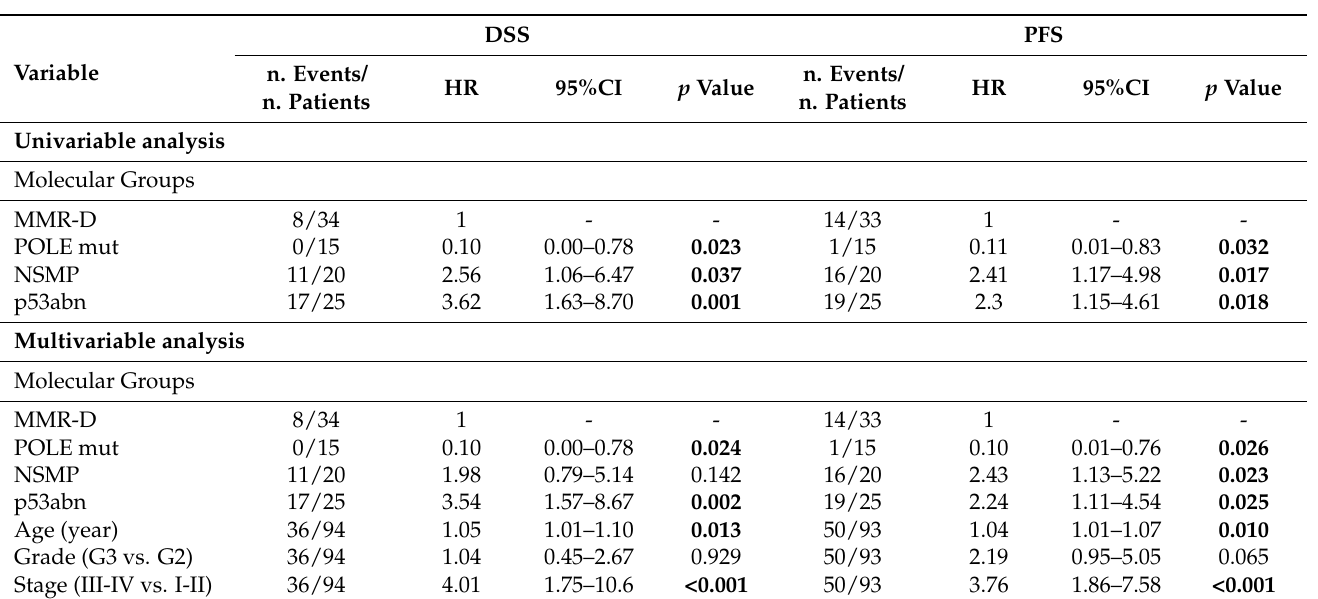
Table 2. Univariable and multivariable survival analysis for Disease Specific Survival (DSS) and Progression Free Survival (PFS) according to molecular classification in the Brescia